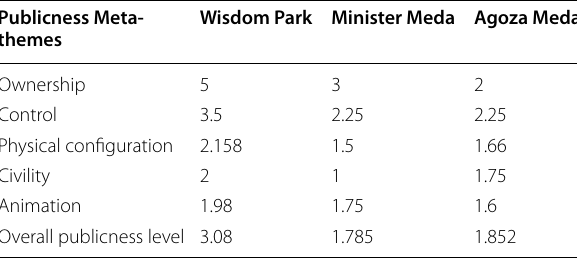
Table 2 Rating of the five meta-themes for the level of publicness of the studied sites